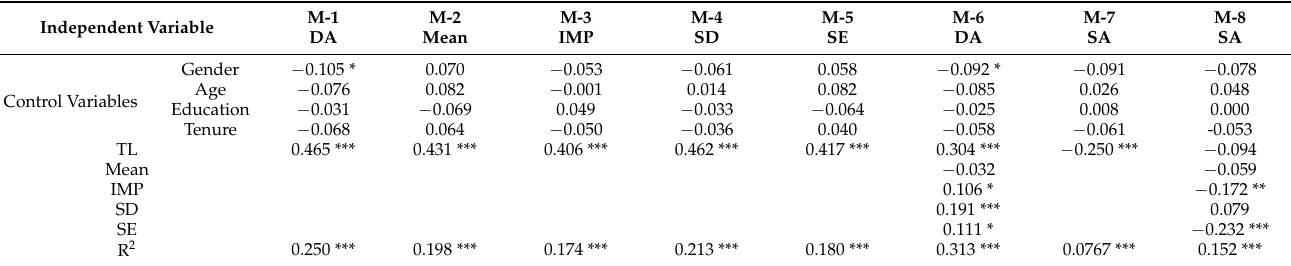
Table 3. The results of mediation tests.